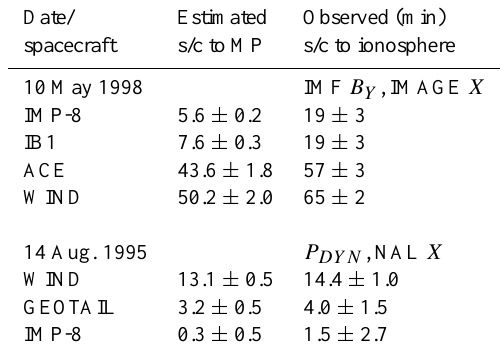
Table 2. The propagation time